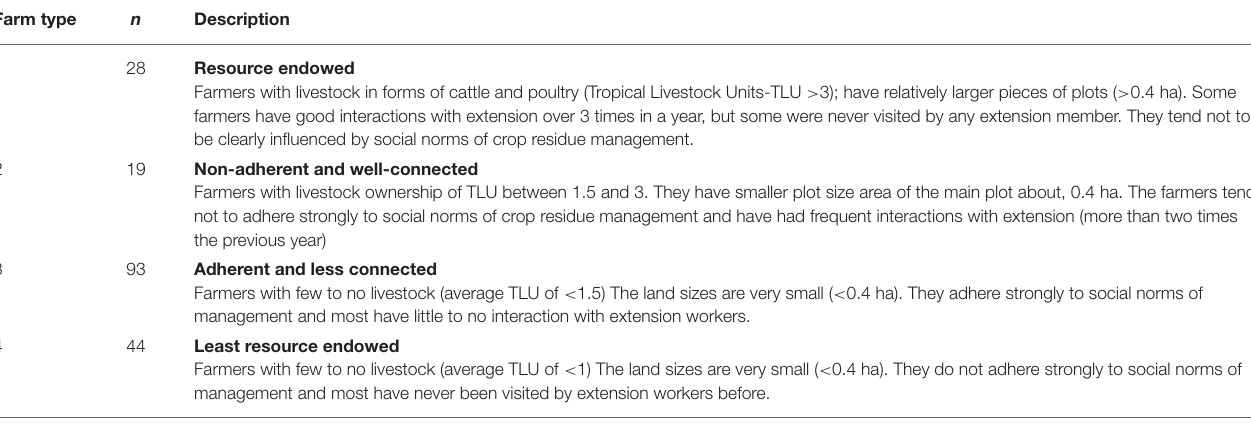
TABLE 9 | Constructed farm typologies using fuzzy k-means classification for organic nutrient sources allocation across 184 farming households Nandi, Vihiga, and Busia counties in western Kenya. Farm